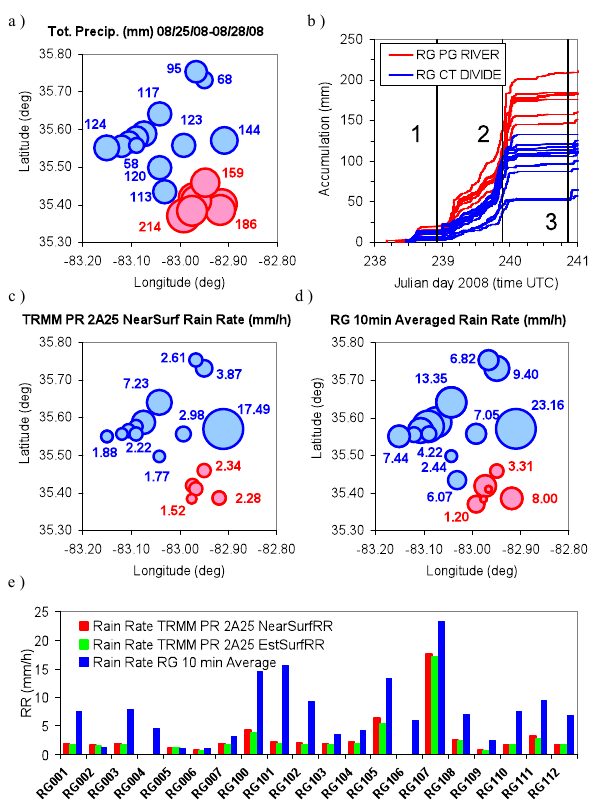
Fig. 5. (a) Total precipitation recorded by the 20 rain gauges (0XX and 1XX) of the GSMNP during the passage of tropical storm Fay from 12:00UTC 08/25/08 to 12:00UTC 08/28/08. (b) Cumulated amount of rainfall and corresponding TRMM overpasses (1: 61409; 2: 61424; 3: 61439). (c) TRMM 2A25 instantaneous near sur- face rain intensity (2: 61424). (d) Rain gauges 10-min rain rate corresponding to TRMM overpass (2: 61424). (e) Comparison of TRMM 2A25 surface rain rates and 10-min rain gauge rain rate for TRMM overpass (2: